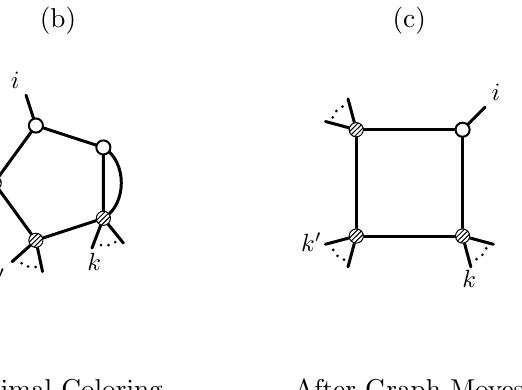
Minimal Coloring After Graph Moves Figure 5 . The Landau diagram (a) appears to have a minimally MHV coloring (b). Yet the corresponding on-shell function is related by the on-shell diagram moves of [24] to one in the NMHV helicity sector